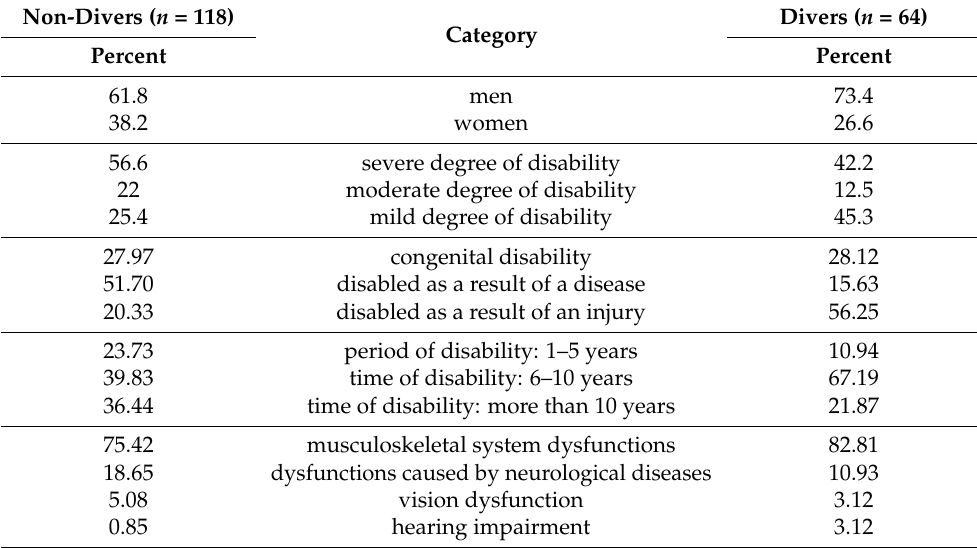
Table 1. Description of the analyzed